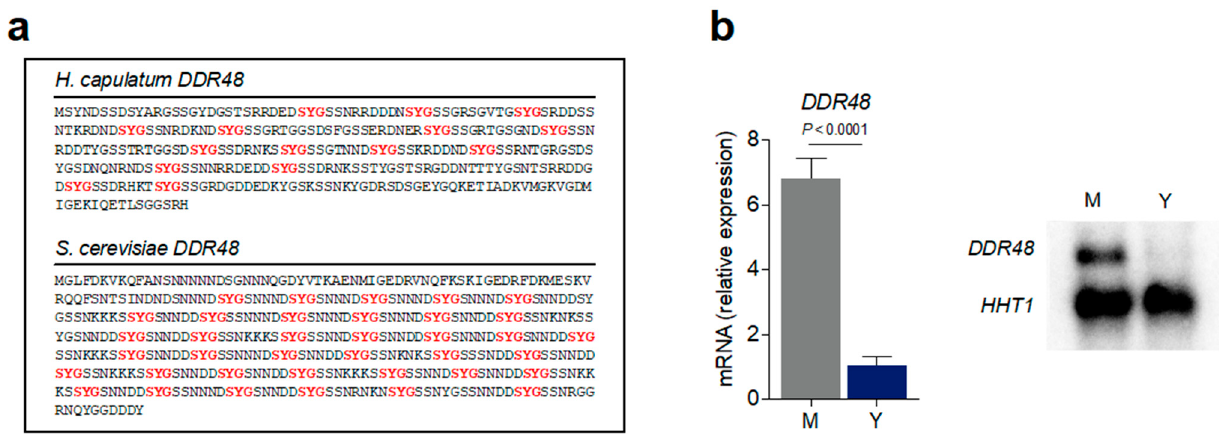
Figure 1. DDR48 gene expression levels are enriched in Histoplasma mycelia. ( a ) amino acid sequence of H. capsulatum DDR48 (top) and S. cerevisiae DDR48 (bottom) showing SYG repeats (red). ( b ) Expression of DDR48 in yeasts (Y) (blue bar) and mycelia (M) (grey bar) growth phases in liquid HMM measured by qRT-PCR (left) and representative northern blot (right) ( n = 12) calculated relative to HHT1 transcript levels. All data generated were performed on three technical replicates and at least two biological replicates. Data is represented as the mean ± standard deviation (SD). Statistical analyses were performed using Student’s t test.